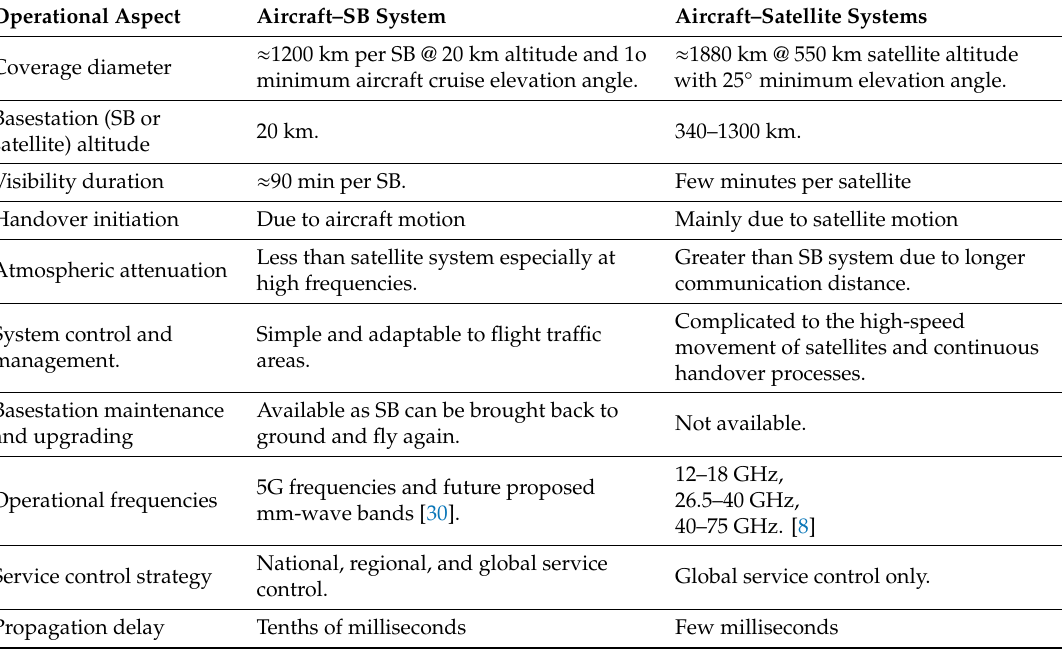
Figure 19. Propagation delay variation with basestation altitude at different minimum elevation angles. Table 2. Comparison between aircraft – SB and aircraft – Starlink satellite networks.